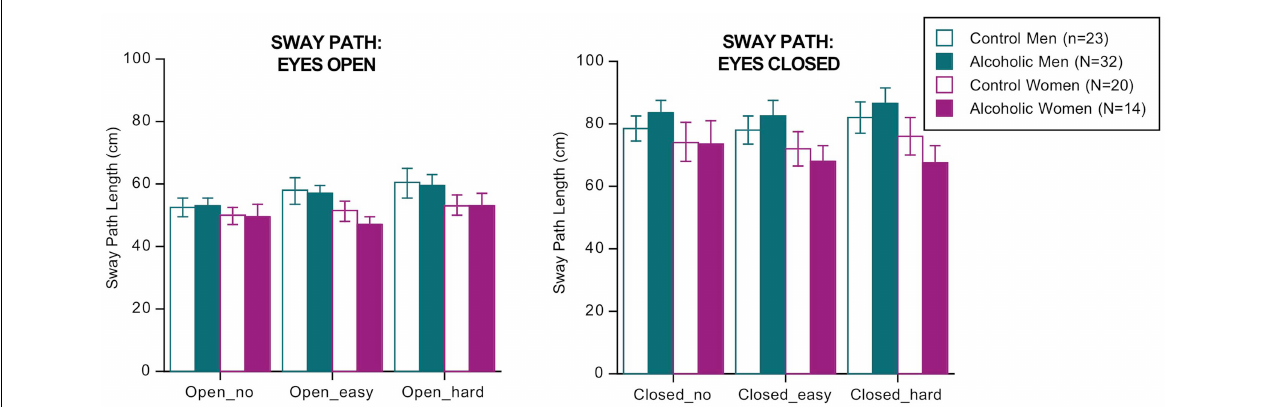
FIGURE 1 | Bar graphs = mean ± SE of the sway path length in each group. None of the group differences was significant.